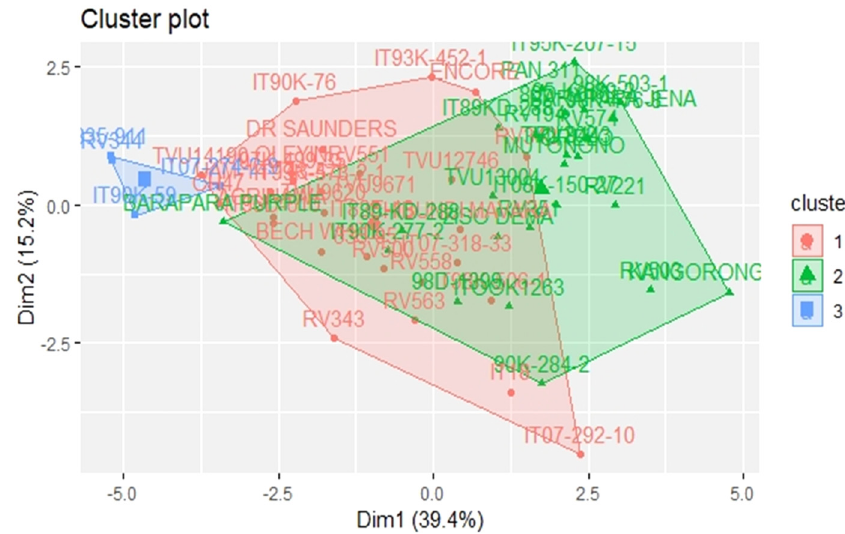
Figure 8: Cluster plot showing the three groups of cowpea accessions grouped according to their levels of drought tolerance. Cluster 1 – moderately tolerant; cluster 2 – susceptible; cluster 3 –